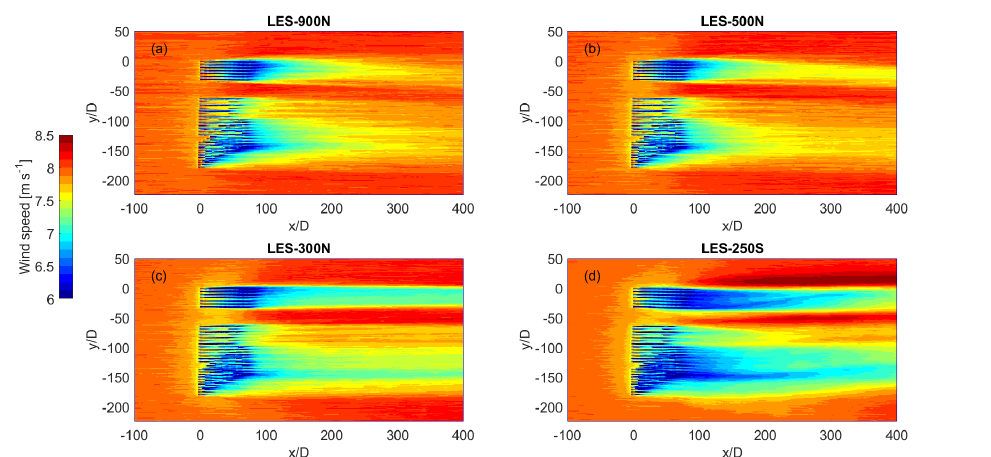
Figure 3. Horizontal cross-sections at hub height of the large-eddy-simulated wind speed for neutral (ABL heights of about ( a ) 840 m (LES-900N), ( b ) 530 m (LES-500N), ( c ) 320 m (LES-300N)) and stable ( d ) 250m (LES-250S) conditions colored according to the colorbar at center. The freestream wind speed is on average 8 m s − 1